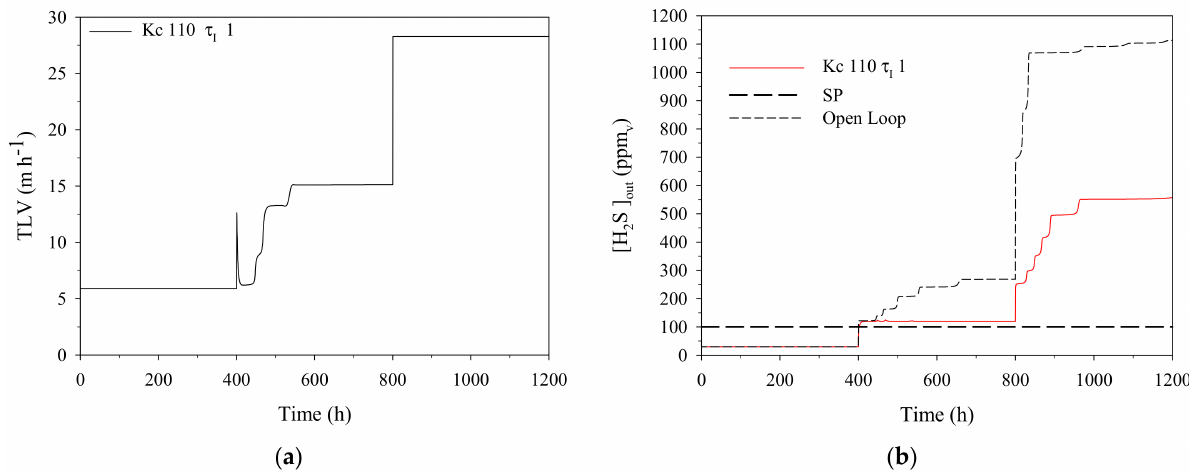
Figure 8. TLV-CL results obtained for the scenario with H 2 S control facing biogas flowrate changes using a PI controller. ( a ) Trickling liquid velocity manipulated variable and H 2 S outlet concentration (controlled variable) ( b